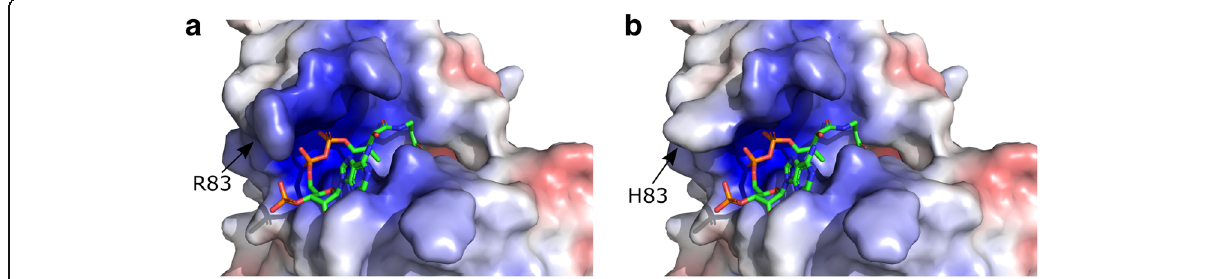
Fig. 3 NAA10-R83H has altered charge distribution at the surface facing Ac-CoA WT R83 a or H83 mutant NAA10 b is shown in a surface model, with residue 83 marked with an arrow. Charge was visualized in PyMOL. Blue denotes positive charge and red denotes negative charge. Ac-CoA is shown as a licorice